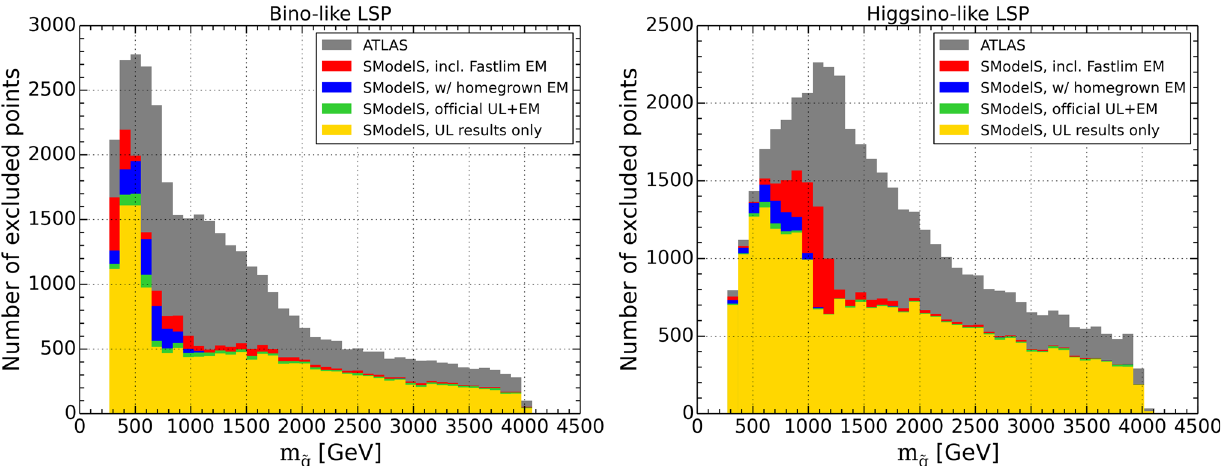
Fig. 1 Number of points excluded by SModelS using only UL results (in yellow), adding official EM results (in green), adding ‘home-grown’ EMs (in blue) and finally adding also Fastlim EMs (in red). For ref-